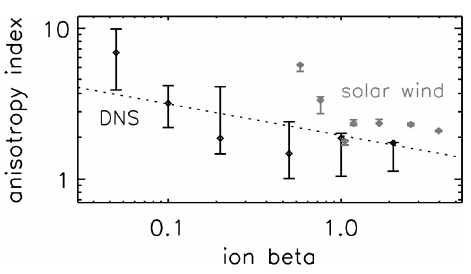
Figure 6. Ion beta dependence of anisotropy index obtained by the Cluster spacecraft measurements in the solar wind (in gray) and that by direct numerical simulation (DNS, in black) with the power-law